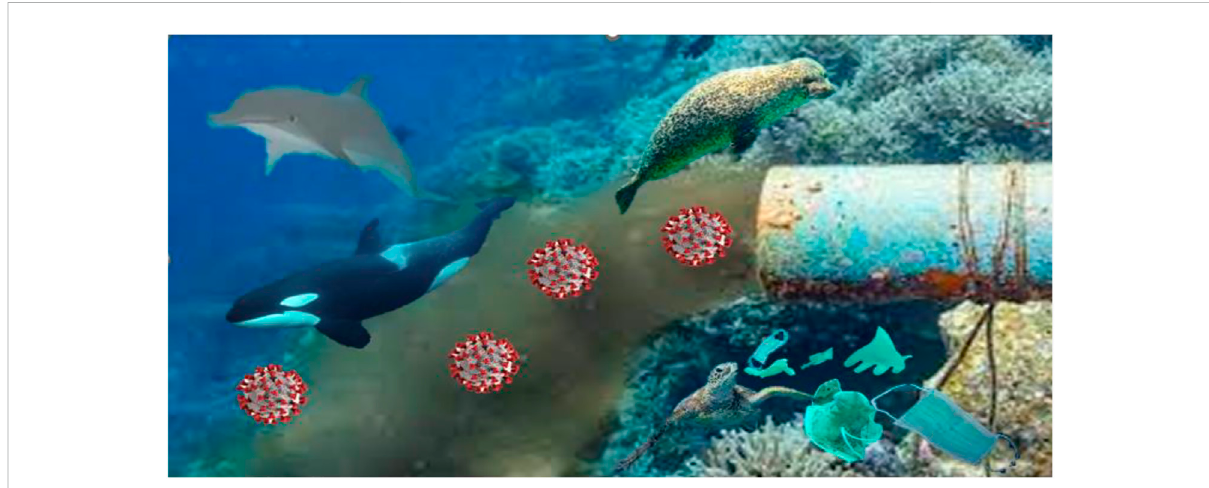
FIGURE 3 Marine life affected by disposal of wastewater containing SARS-CoV-2 and personal protective